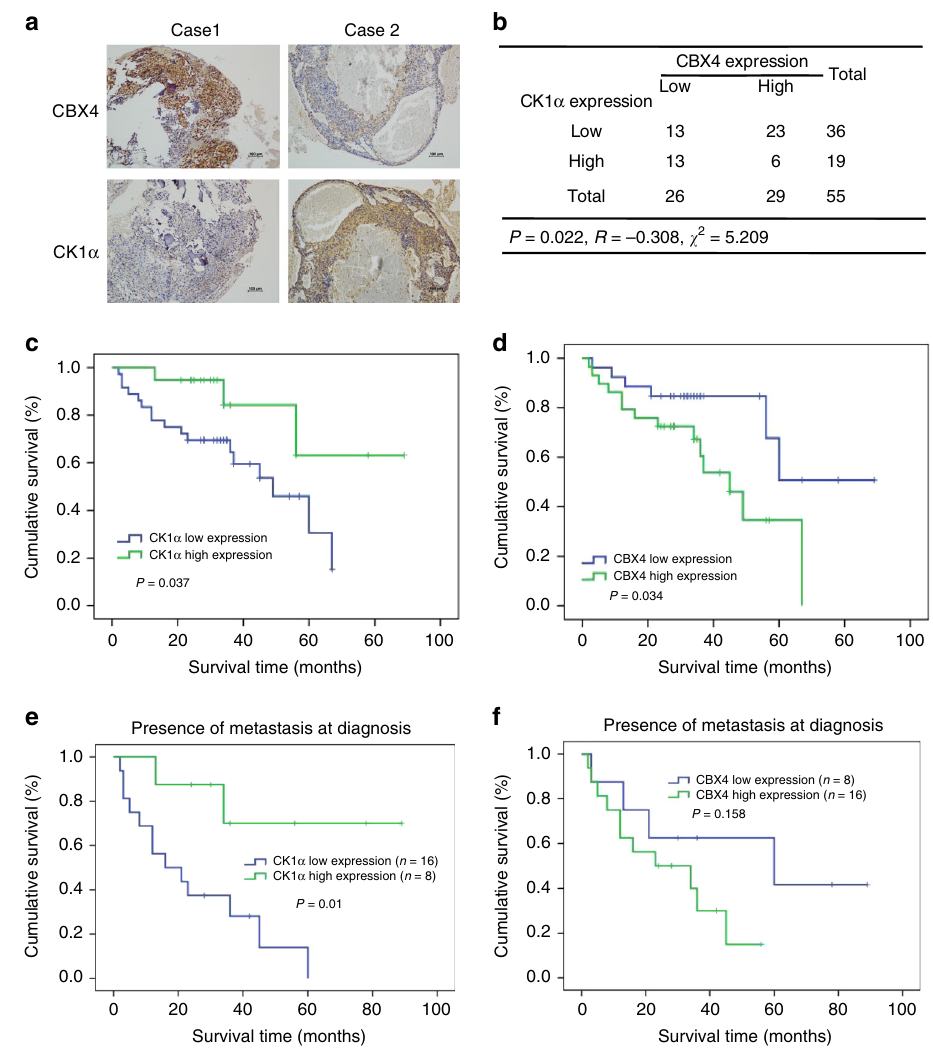
Fig. 6 Reverse correlation between CK1 α and CBX4 in osteosarcoma tissues. a Representative immunohistochemical staining images of both CBX4 and CK1 α for 55 paraf fi n-embedded osteosarcoma tissues. Scale bar: 100 μ m. b A positive correlation was observed between CBX4 and CK1 α protein levels in the osteosarcoma tissues used in a ( p = 0.022, χ 2 tests. R : Spearman correlation coef fi cient). * p < 0.05 using the two-sided Pearson chi-squared tests. c – f Overall survival curves were generated based on the protein levels of CK1 α ( c , e ) or CBX4 ( d , f ) in the osteosarcoma tissues used in a . * p < 0.05 using Kaplan – Meier plots and compared with the log-rank were seeded with 0.5 ×10 5 (U2OS cells) or 1× 10 5 (U2OS/MTX300 cells) in 200 μ l Solution (1/10 the volume of the growth medium volume) was added to the existing culture medium. The fi xation reaction was stopped by adding Stop Solu- of serum-free DMEM without an extracellular matrix coating. DMEM containing tion (1/20 the volume of the growth medium volume) to the existing culture 20% FBS was added to the bottom chamber. After approximately 24h of incuba- medium. The cells were collected by centrifugation, and the nuclear pellet was tion, the cells on the lower surface of the fi lter were fi xed, stained, and examined resuspended in ChIP Buffer. The cell lysate was subjected to sonication and then using a microscope. For the invasion assay, the membrane was coated with 50 μ l of incubated with 5 μ g of antibody overnight, followed by incubation with the protein 1:8 diluted Matrigel (BD Biosciences, USA). After the Matrigel had solidi fi ed at 37° A/G agarose beads overnight at 4 °C. Bound DNA-protein complexes were eluted, and cross-links were reversed after a series of washes. The puri fi ed DNA was resuspended in TE buffer for PCR analysis. The primers for the indicated pro- chamber was fi lled with DMEM containing 20% FBS. The Boyden chamber was moters are shown in Supplementary Materials. then incubated at 37°C in 5% CO 2 for approximately 24h. The cells were then stained and observed as described for the migration assays. MTT assay . A 3-(4,5-dimethylthiazol-2-yl)-2,5-diphenyltetrazolium bromide (MTT) assay was used to measure cell viability. Brie fl y, U2OS or U2OS/MTX300 cells were seeded at a density of 2000 cells per well in a 96-well microplate. The cells were incubated with MTT for 4h, and the optical density (OD) was detected at 490 nm with the microplate reader once per day for 4 days. The results are presented as the mean ±SD of three independent experiments. Migration and invasion assays . Transwell assays using Boyden chambers con- taining 24-well transwell plates (BD Inc., USA) with an 8 μ m pore size were used to evaluate the migration and invasiveness of cells. All experiments were performed in duplicate and repeated three times. For the migration assay, the cell culture inserts